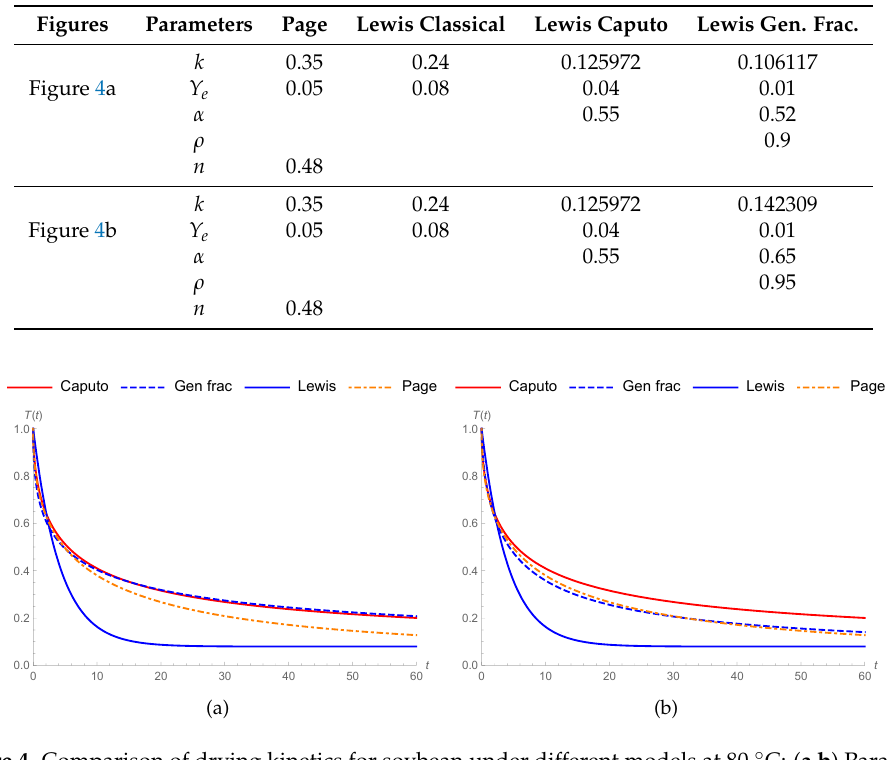
Figure 4. Comparison of drying kinetics for soybean under different models at 80 ◦ C: ( a , b ) Parameter values are shown in Table